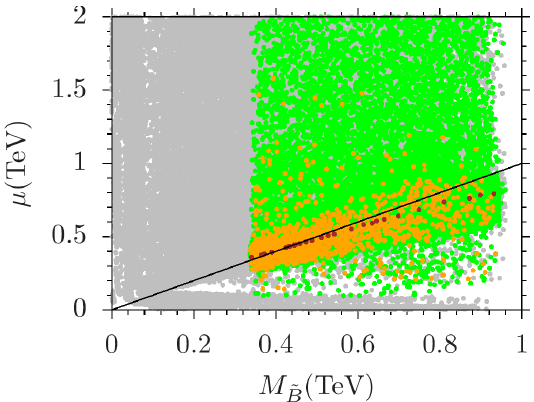
Figure 9 . Plots for the neutralino species in the µ − M ˜ the values at the low scale. The color coding is the same as figure 5. The diagonal line shows the solutions in which the Higgsinos and Bino are degenerate in mass ( µ = M ˜